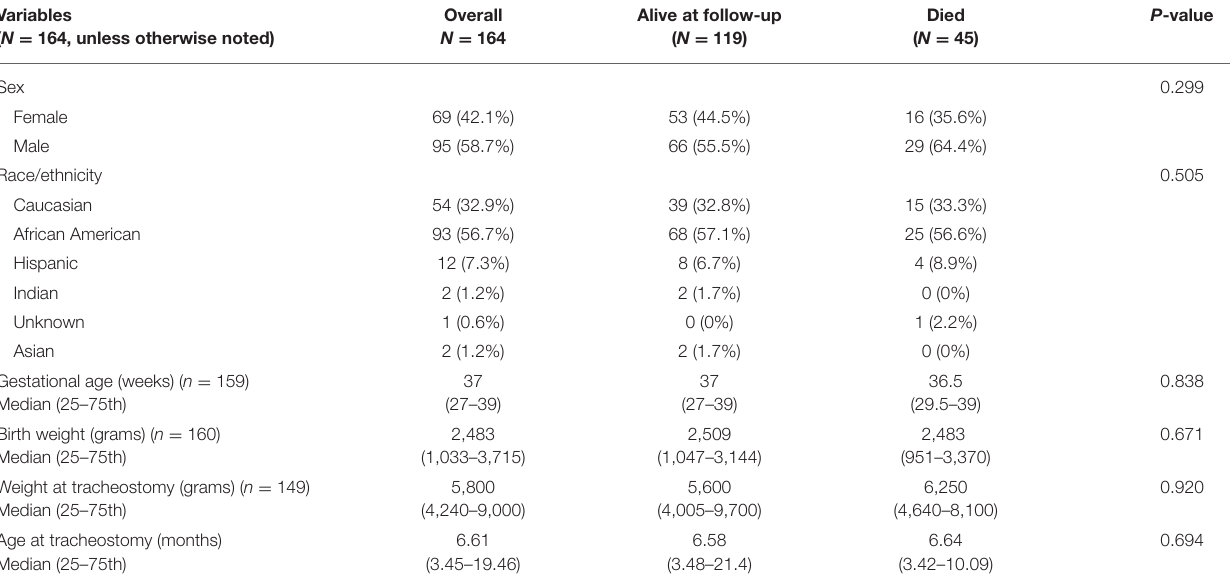
TABLE 1 | Demographics and outcomes of pediatric tracheostomy cohort.